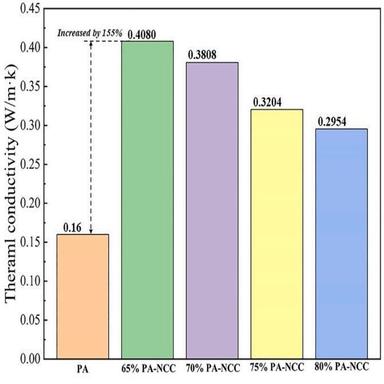
Thermal conductivity of PA,65 % PA-NCC, 70 % PA-NCC, 75 % PA-NCC and 80 % PA-NCC.